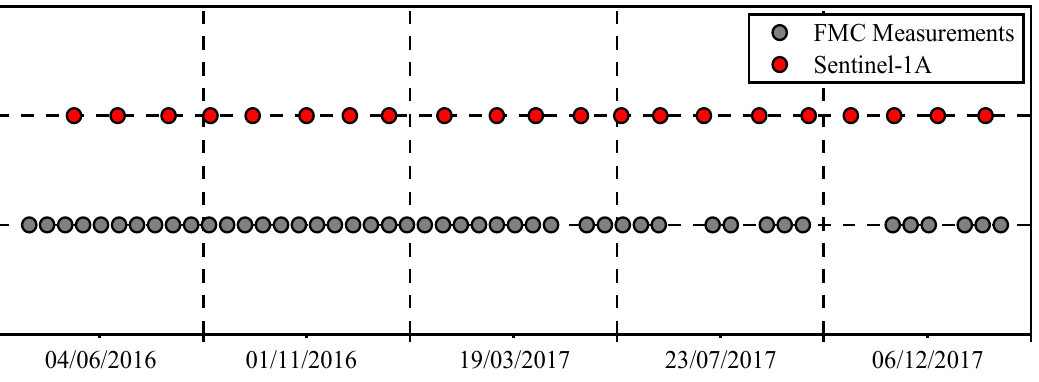
Figure 3. Overview of the temporal coverage of acquired 46 Sentinel-1A data and 21 field forest FMC data.